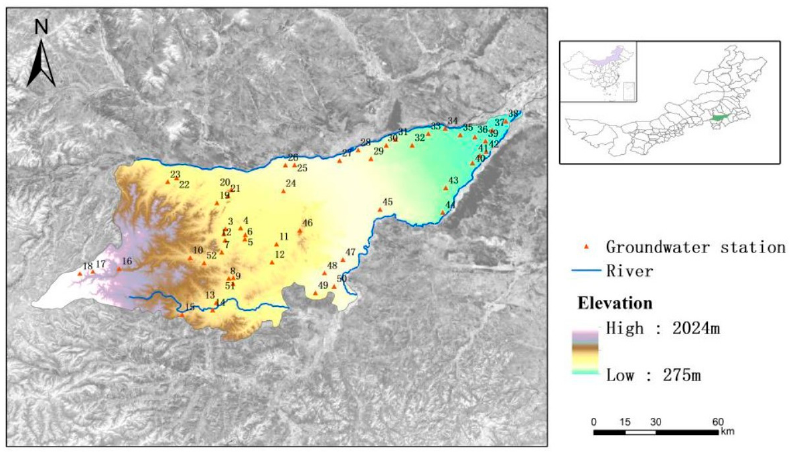
Figure 1. Distribution of the study area and groundwater station.